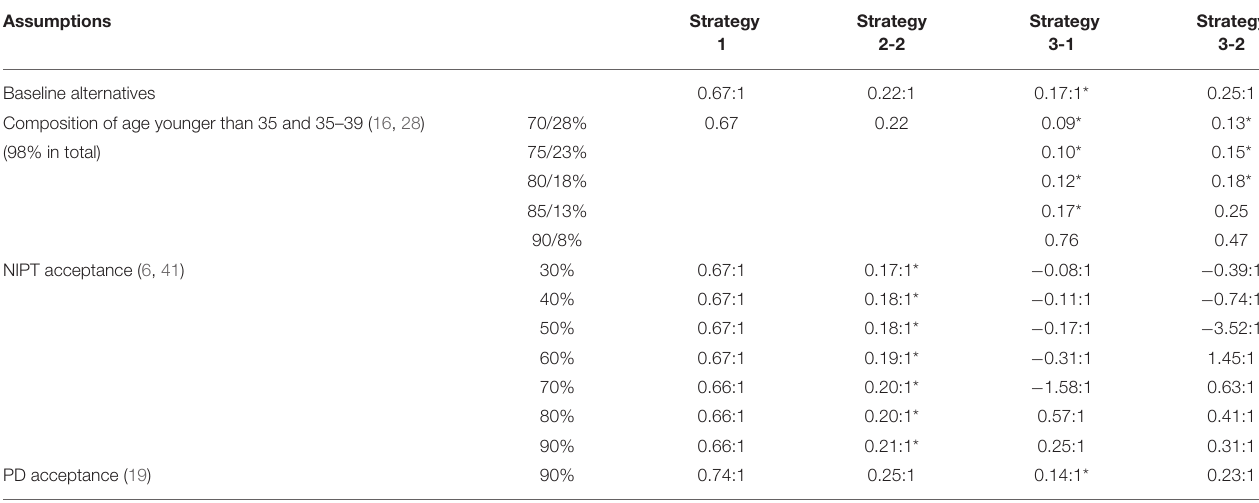
TABLE 3 | The incremental cost analysis setting Strategy 2-1 as baseline (Million US$).